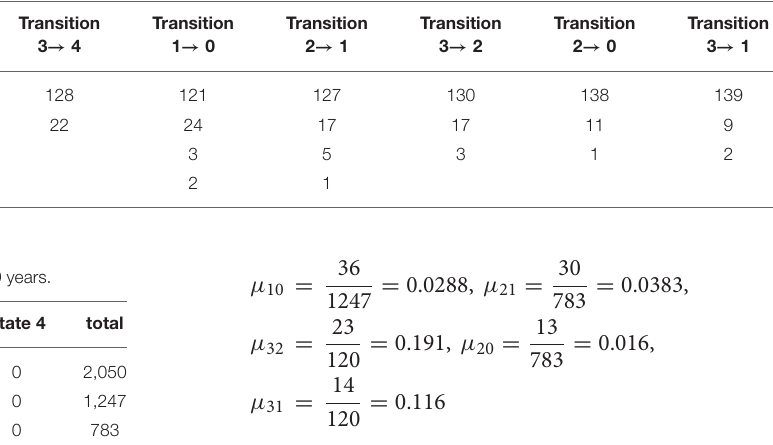
TABLE 1 | Summary of transition counts among the states.